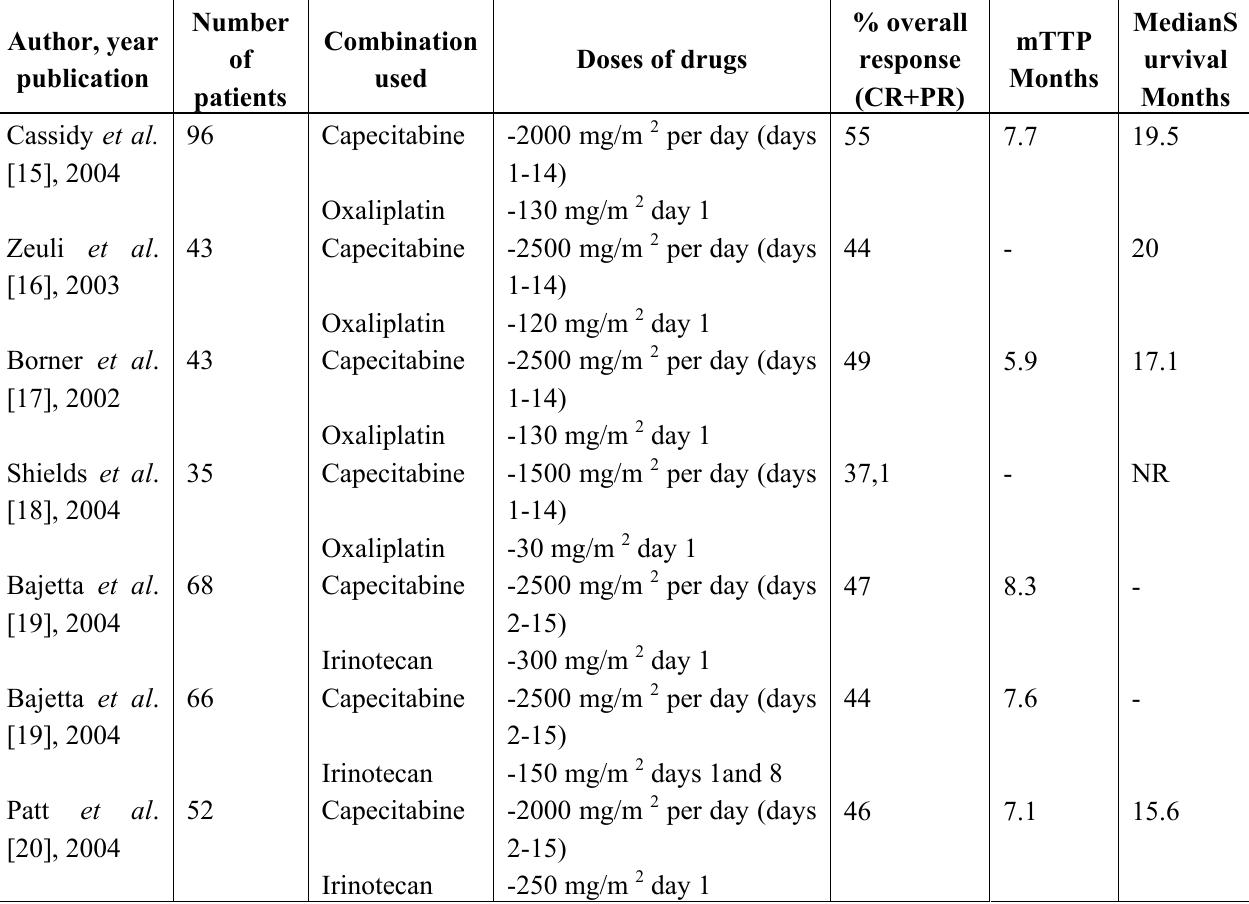
Table 2. Phase II studies combinations of Capecitabine with irinotecan or oxaliplatin in metastatic colorectal